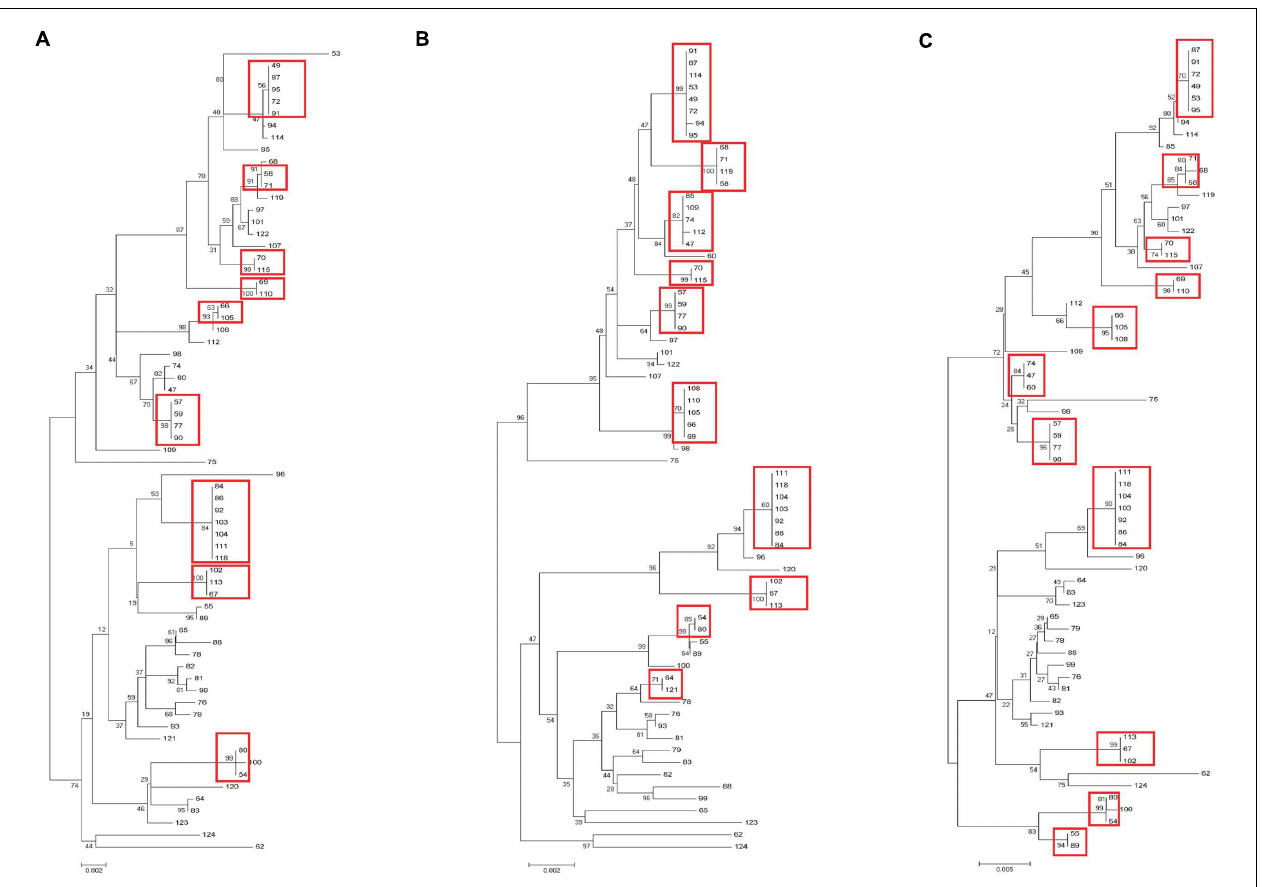
FIGURE 4 | Phylogenetic trees of 67 clinical UPEC strains based on (A) four genes ( yagV , fimF , fimH , and fumC ), (B) MLST genes, and (C) the internal fragments of fimH and fumC . The scales at the bottoms of the trees indicate phylogenetic distance. Bootstrap values are displayed as percentages on nodes. Closely related strains are shown in red boxes.